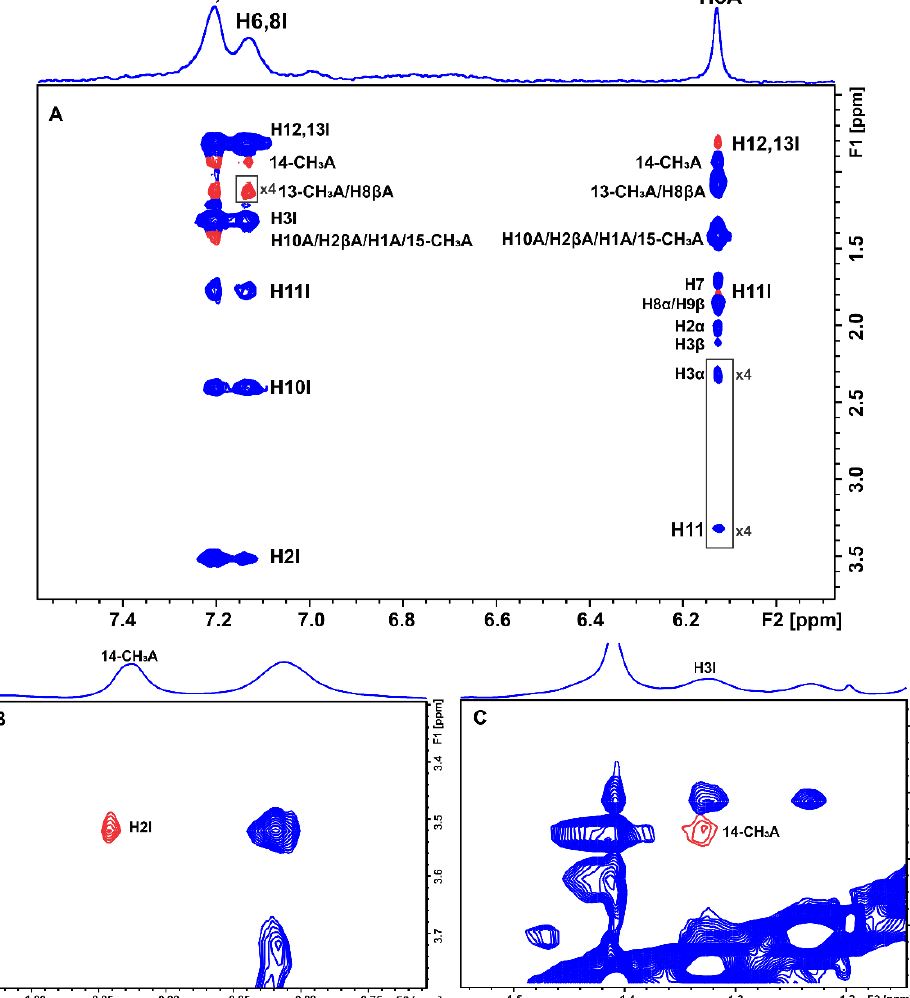
Figure 8. Selective regions of 2D Tr-NOESY NMR spectrum (d8 = 300 ms) of 2 mM artemisinin and 20 µ M BSA after the addition of 1.2 mM ibuprofen in PBS buffer solution in D 2 O, pD 7.4 with 10% DMSO-d 6 . Blue cross-peaks correspond to intra-NOEs and red cross-peaks to inter-NOEs. For the notation of inter-NOEs in ( A – C ), see text. The NMR parameters are the same as in Figure 3.